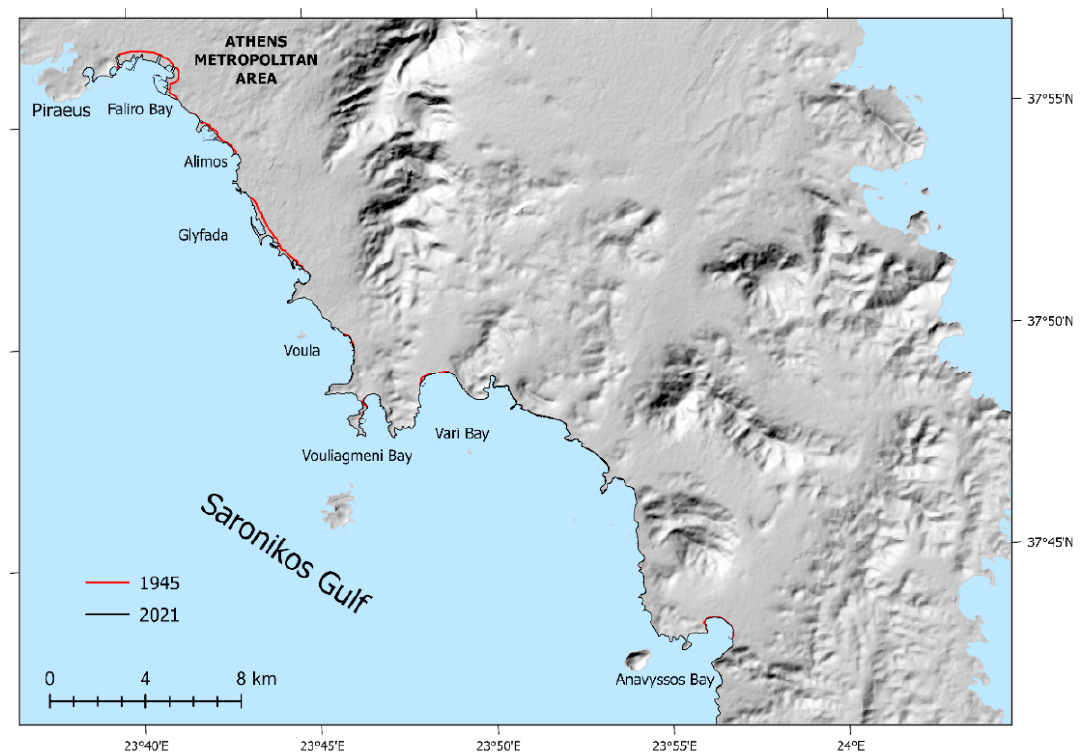
Figure 11. The coastlines of 1945 and 2021 as well as their temporal changes in Athens Riviera.